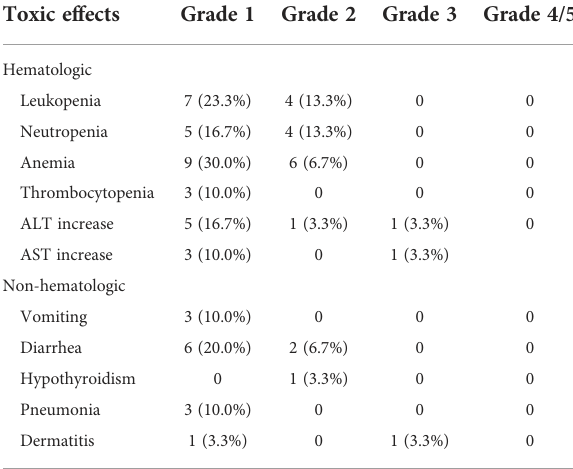
TABLE 4 Treatment-related adverse events [N = 30, No. (%)].